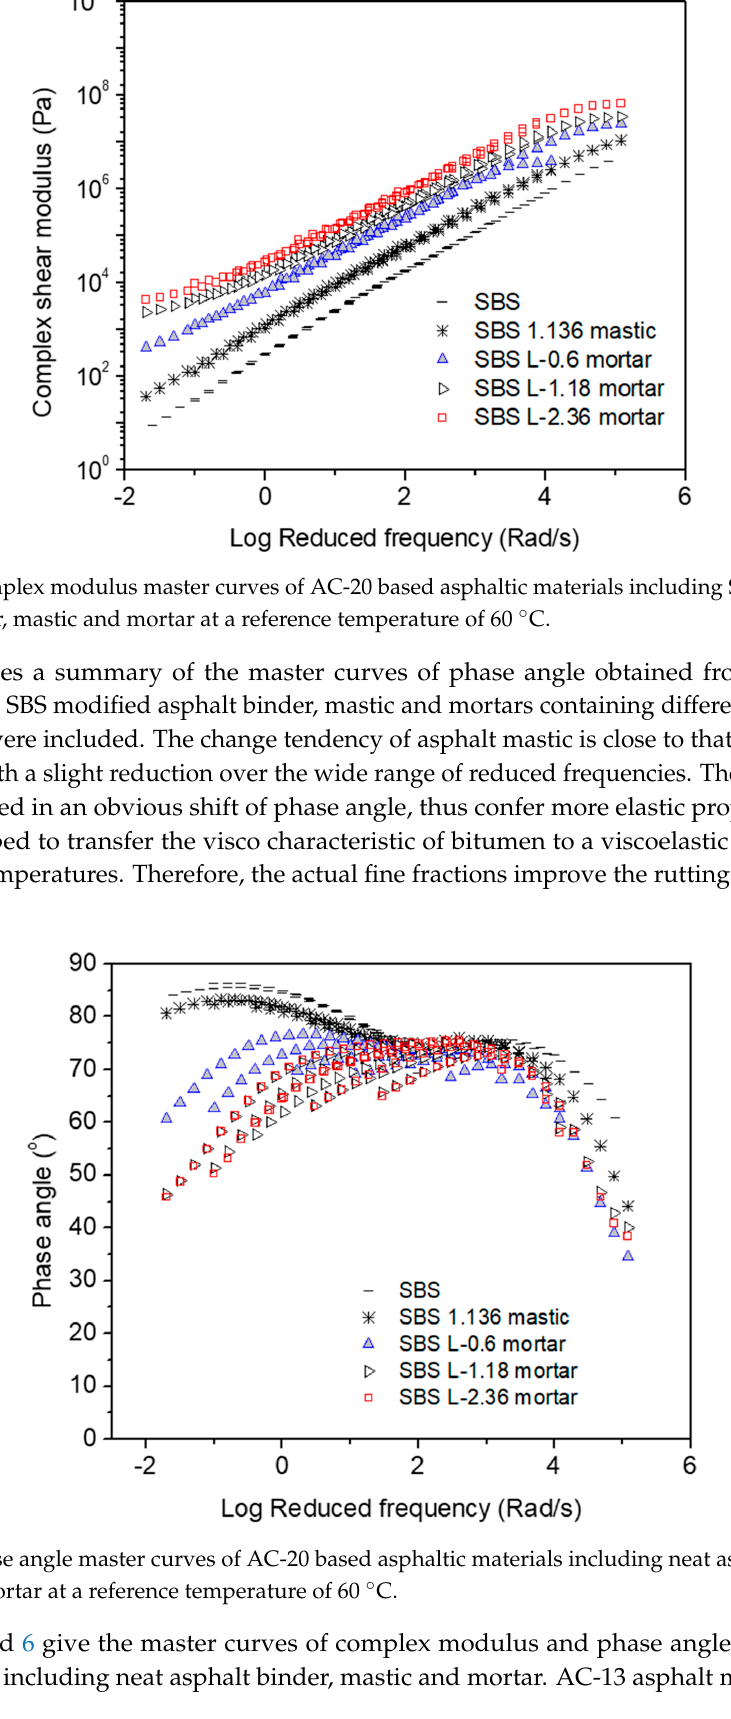
Figure 4. Phase angle master curves of AC-20 based asphaltic materials including neat asphalt binder, mastic and mortar at a reference temperature of 60 °C.